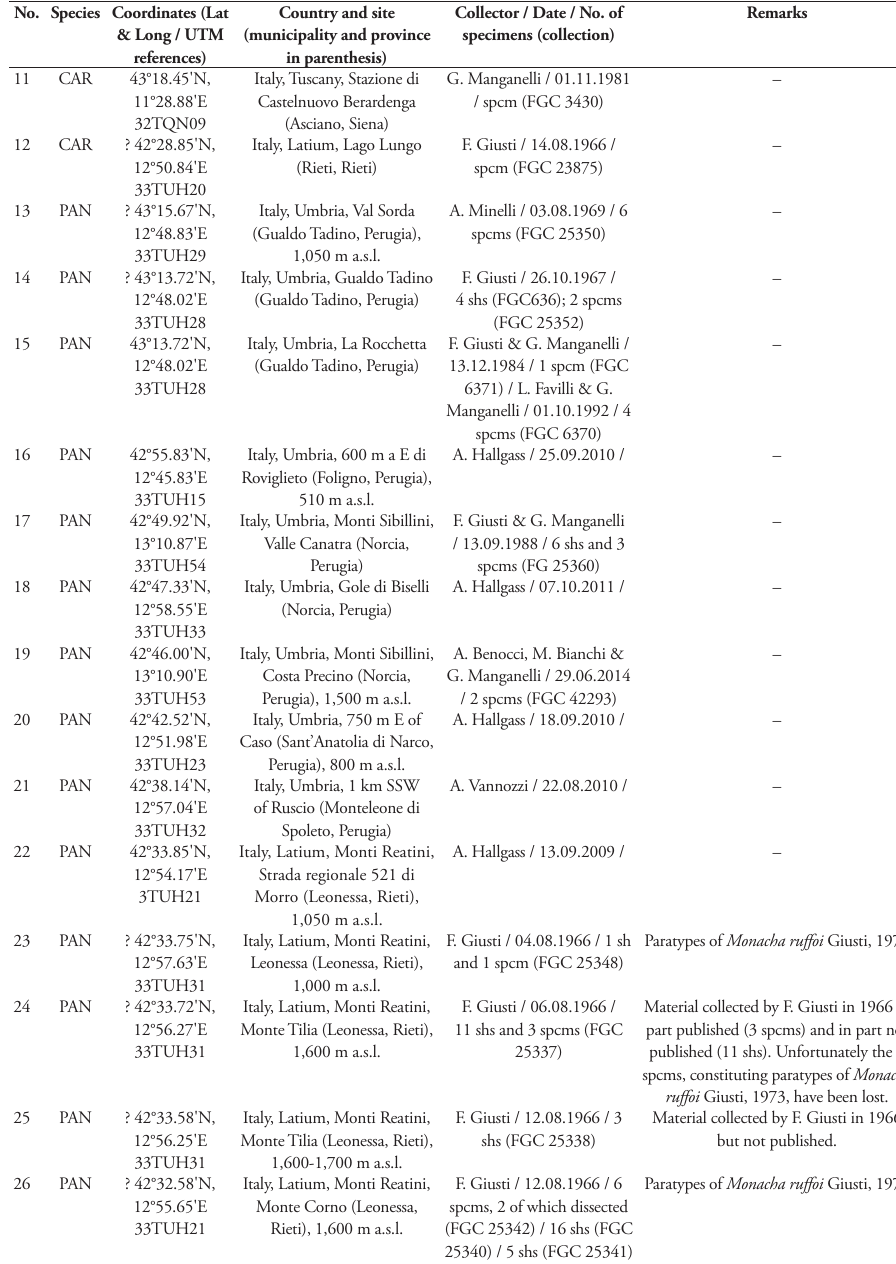
Table 3. Populations and materials of Monacha cartusiana (CAR) and Monacha pantanellii (PAN) not listed in Table 1 because they were not included in the molecular and statistical morphological analysis (apart from additional morphological analysis of M. cartusiana ). A question mark before the geographical coordinates of some localities denotes that the georeferencing was done a posteriori on the basis of the available